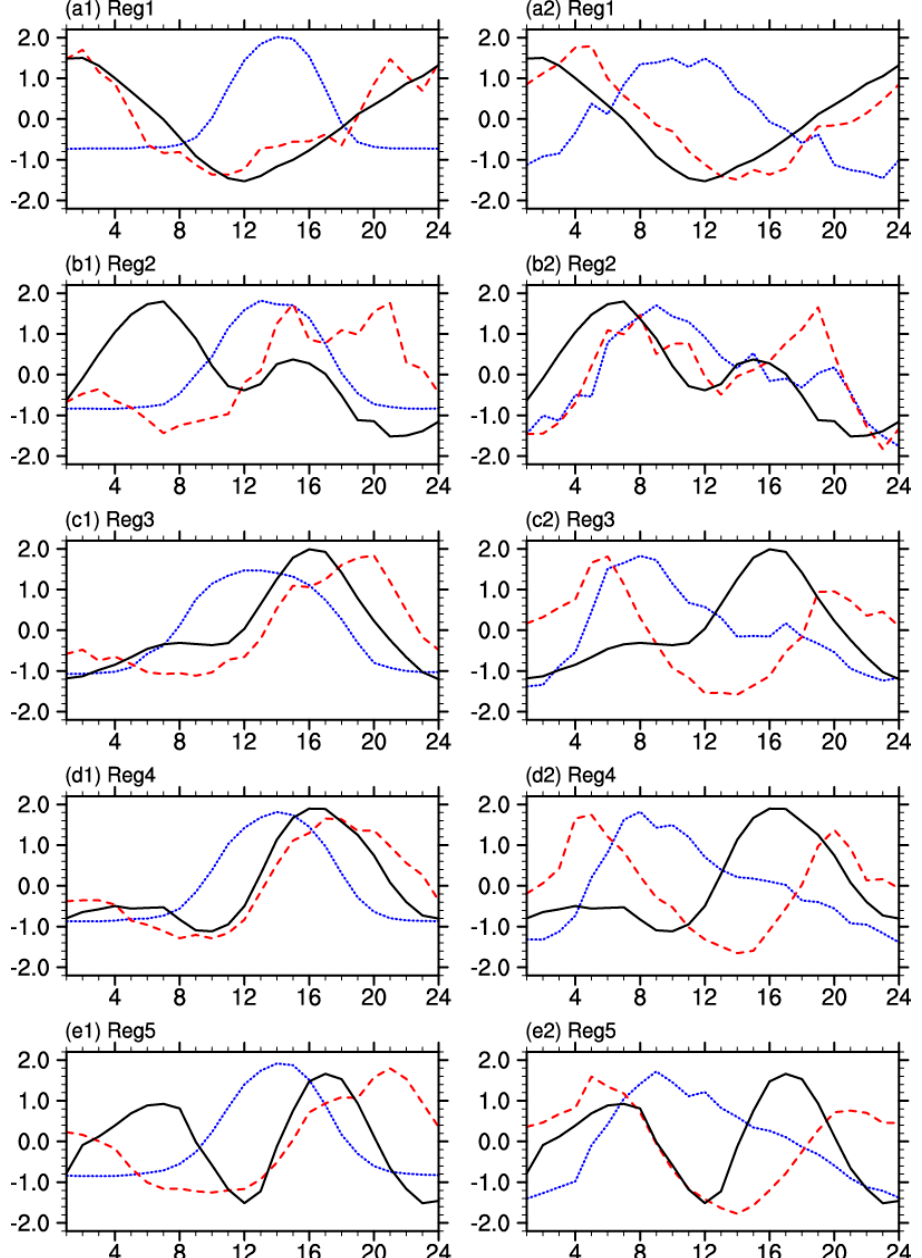
Figure 7. Diurnal variations of the standardized occurrence frequencies of Cu, Cb and precipitation (in Figure 7a1 – 7e1 ) and of the standardized occurrence frequencies of Ns, Sc and precipitation (in Figure 7a2 – 7e2 ) (the black solid line corresponds to precipitation, while the blue dotted line and red dashed line represent the occurrence frequencies of Cu and Cb, respectively, in Figure 7a1 – 7e1 ; meanwhile, the blue dotted line and red dashed line represent the occurrence frequencies of Ns and Sc, respectively in Figure 7a2 – 7e2 ).